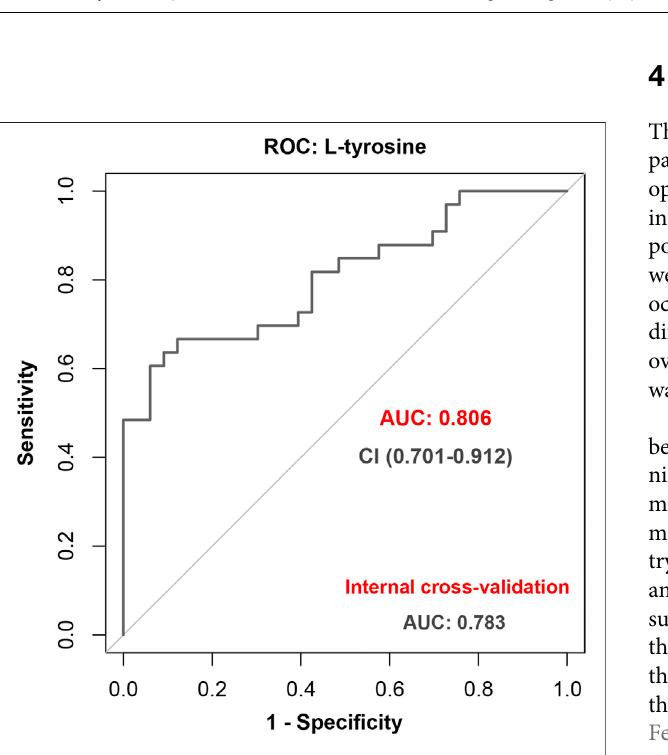
FIGURE 3 | Heat map of differential metabolites between emergence agitation (EA) and non-EA patients.